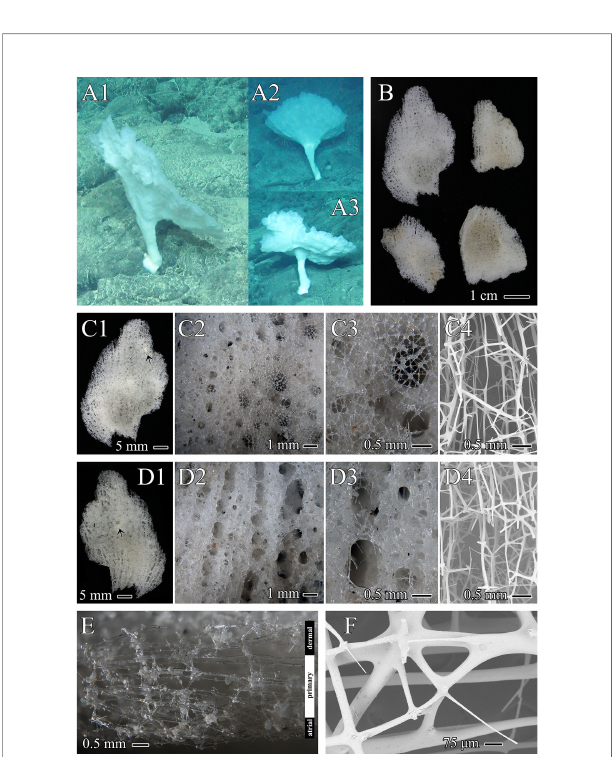
FIGURE 3 | Chonelasma tyloscopulatum sp. nov., specimen, surfaces and skeletons of holotype. (A) In situ images of holotype (A1) and two other same morphotypes (A2, A3) . (B) Whole collected specimen of holotype including four segments (dermal surface upward). (C) Dermal surface, close-up images in different scales with epirhyses in surface view (C1 – C3) , symbiotic anthozoan indicated by an arrowhead (C1) and SEM of cleaned skeleton (C4) , growth margin upward. (D) Atrial surface, close-up images in different scales with aporhyses in surface view (D1 – D3) , symbiotic anthozoan indicated by an arrowhead (D1) and SEM of cleaned skeleton (D4) , growth margin upward. (E) Vertical-longitudinal section of the dictyonal framework, consisting of dermal cortex, primary middle layer and atrial cortex, dermal side upward. (F) Close-up view of dermal cortex with digitate spurs